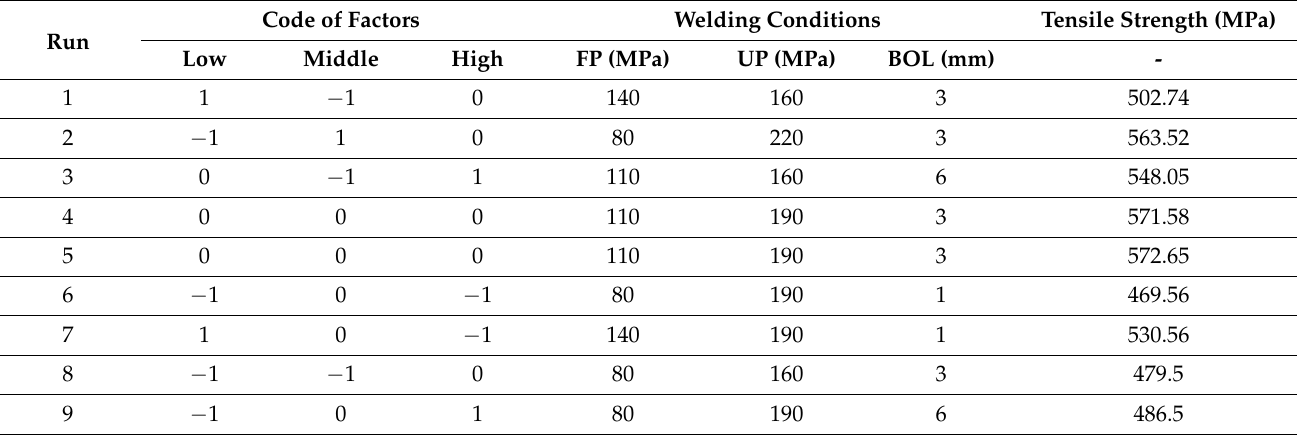
Table 4. Box–Behnken design matrix and experimental results of the tensile